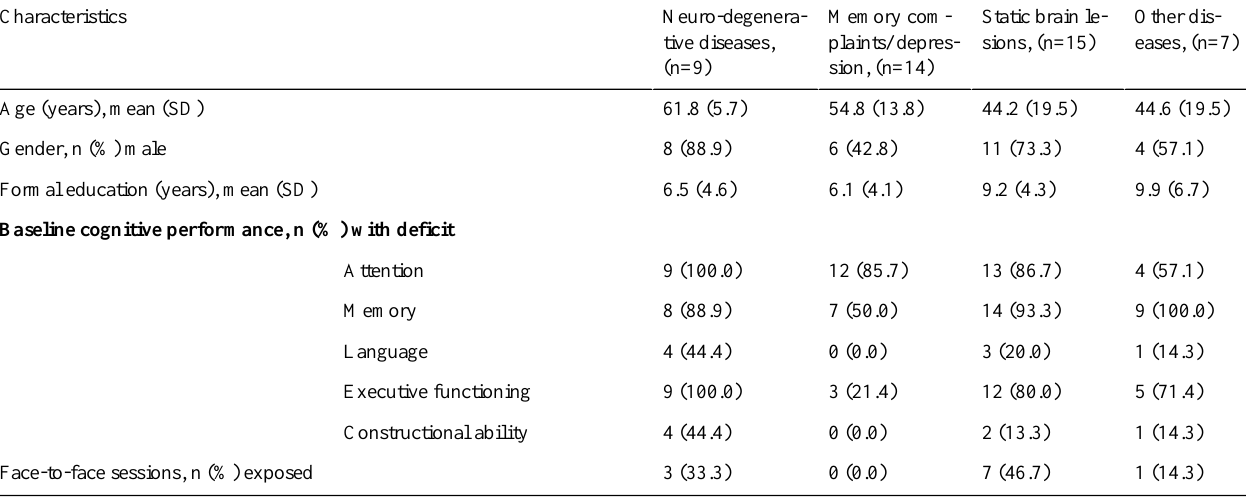
Table 1. Demographic characteristics of all groups.